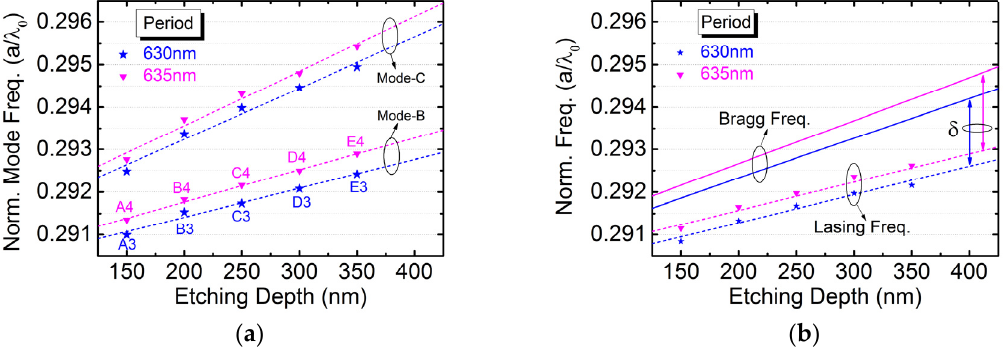
Figure 7. ( a ) The normalized band-edge mode frequency as well as ( b ) the normalized lasing and Bragg frequency is plotted against etching depth for 630- and 635-nm-period devices.